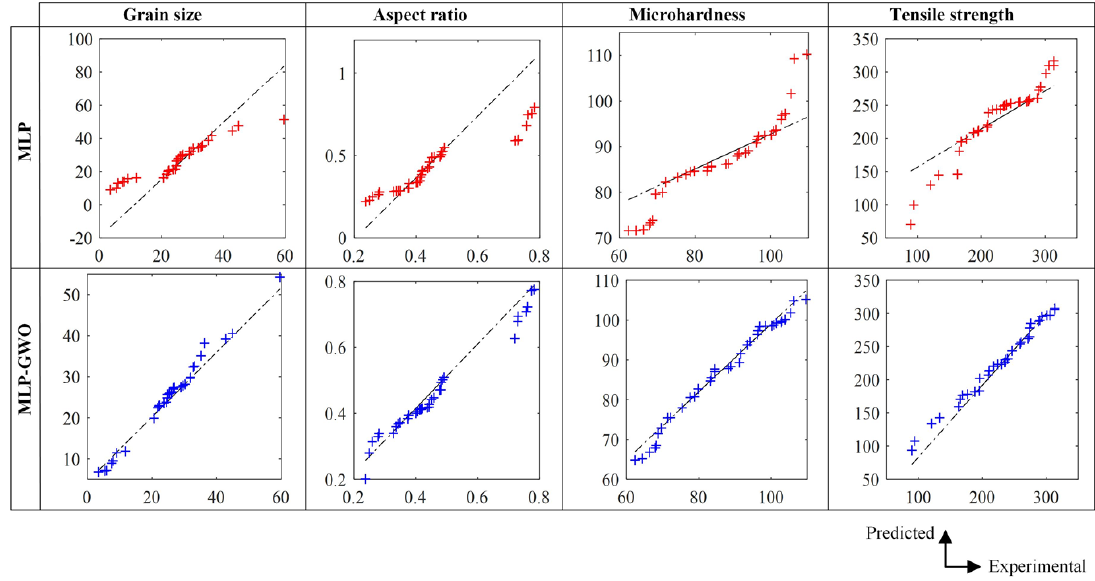
Figure 12. The normalized error plots and error histograms for all predicted responses using MLP and MLP-GWO. Figure 13 shows QQ plots for all predicted responses, particularly grain size, aspect ratio, microhardness, and tensile strength using MLP and MLP-GWO. In these plots, the spread of plotted points away from the straight line reveals the deficiency of the predictive model. The predicted responses of MLP have a poor fitting with the experimental ones for all predicted responses (red color plots), while the predicted responses of MLP-GWO have a good fitting with the experimental ones for all investigated cases (blue color plots). MLP.